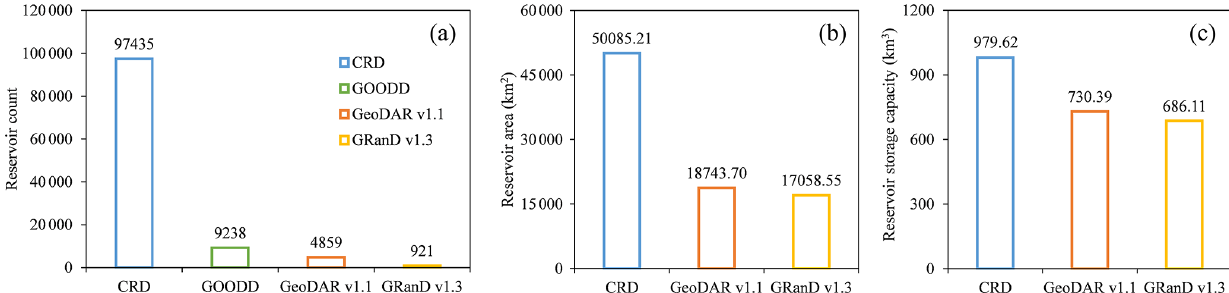
Figure 8. Comparison of reservoirs in count (a) , area (b) , and storage capacity (c) between the CRD database, GOODD, GeoDAR v1.1, and GRanD v1.3 database.